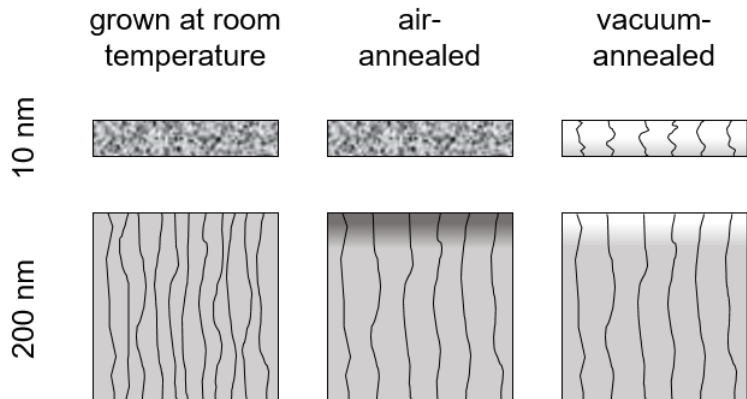
Figure 6. Effect of annealing of 10 and 200nm-thick ITO films deposited at room temperature. The annealing was performed with a heating rate of 0.5K/min up to 200 ◦ C and a holding time of 1h either in vacuum or in air. Curved lines indicate grain boundaries and filling color the oxygen concentration. The filling style of the as-grown and the air-annealed 10nm-thick sample indicates their amorphous structure.